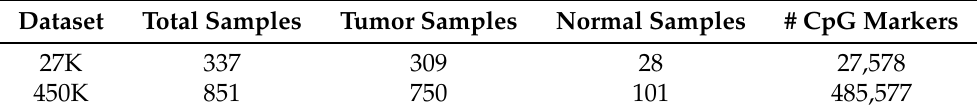
Table 1. Characterization of CpG markers in the breast cancer